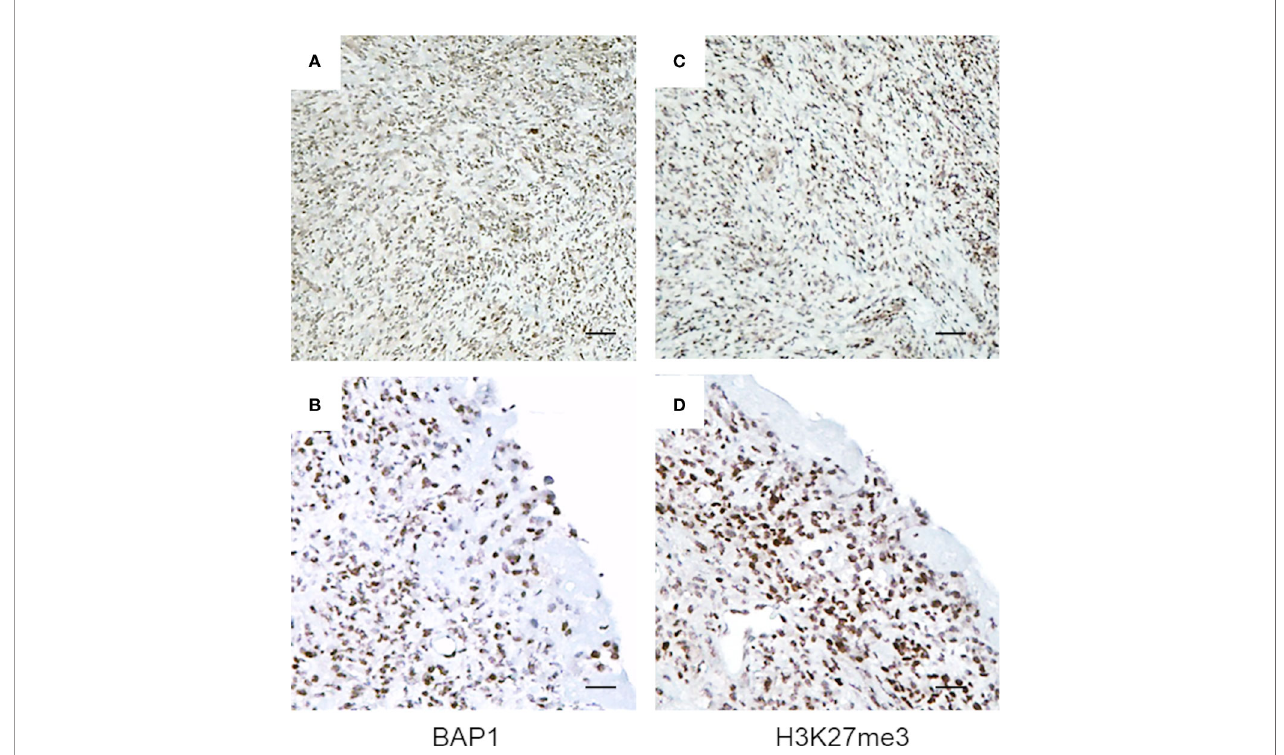
FIGURE 1 | BAP1 wild-type MPM tumor biopsies exhibit high immunoreactivity for H3K27me3. Representative images of immunostaining. Byphasic MPM tissue samples were stained for BAP1 (A, B) and H3K27me3 (C, D) . Images were captured at magni fi cation ×40 (A, C) and ×200 (B, D) using light microscopy. Scale bar = 100 m